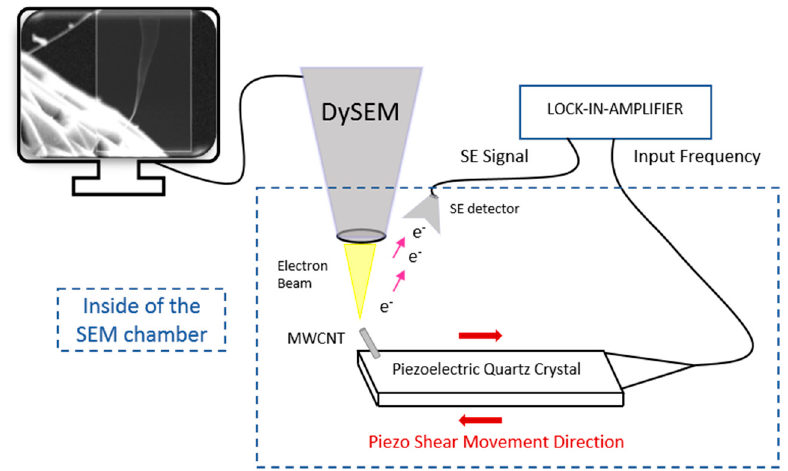
Figure 4. Experimental setup of the dynamic scanning electron microscopy (DySEM) technique used to measure the resonance frequencies of MWCNTs.